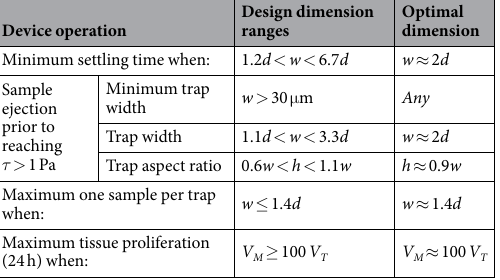
Table 2. Device width w and height h compared to tissue diameter d to optimize device operation.